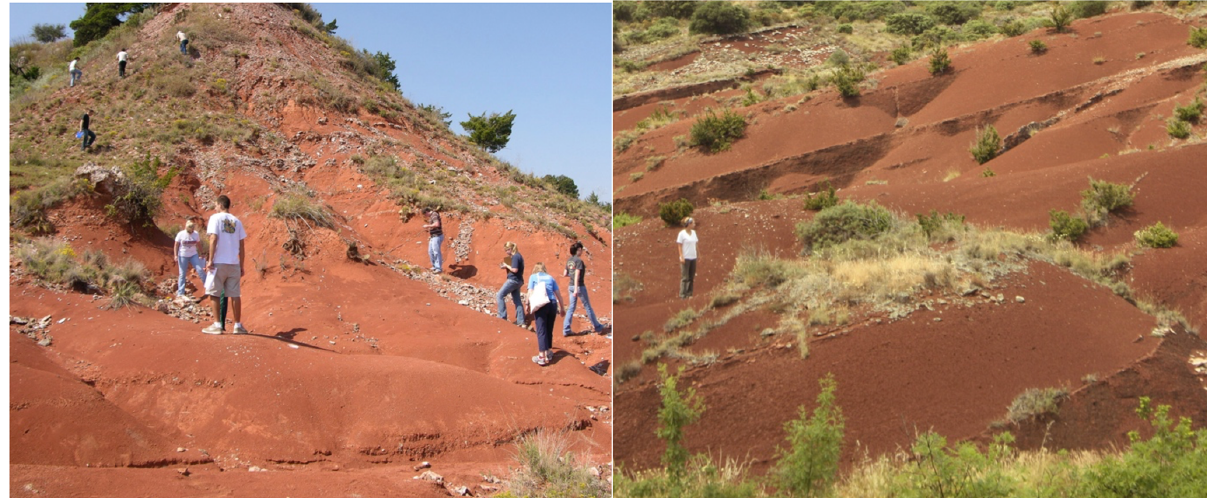
Figure 4. Examples of the lower Permian paleo-loess of (left) the mid-continent US and (right) France. Left: the middle Permian Flowerpot Shale of the Anadarko Basin, western Oklahoma (Sweet et al., 2013). Right: the middle Permian Salagou Formation of the Lodève Basin, southern France (Pfeifer et al., 2016, 2020a,